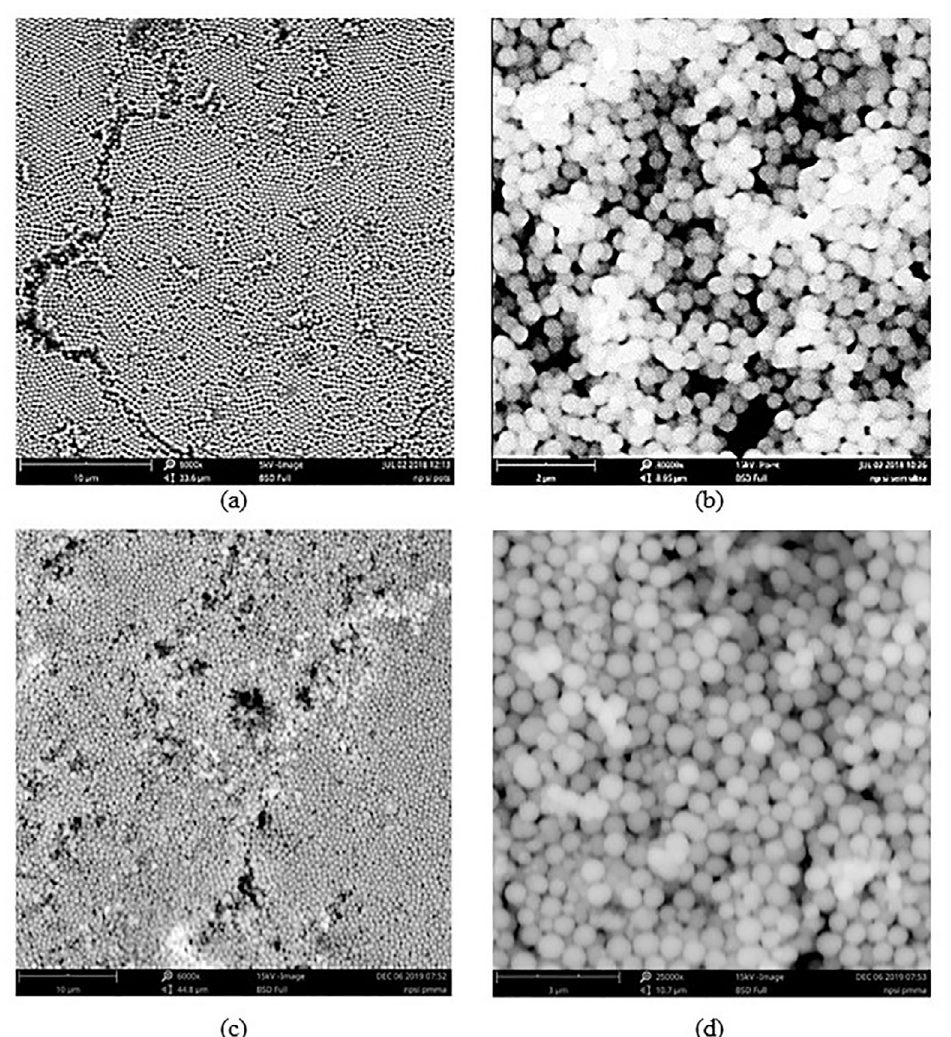
Figure 4. Micrography of the silica nanoparticles on a PMMA board, performed in a SEM. (a) functionalized with POTS magnification by 5,500 times; (b) functionalized with POTS magnification by 30,000 times; (c) not functionalized magnification by 6,000 times; (d) not functionalization magnification by 25,000